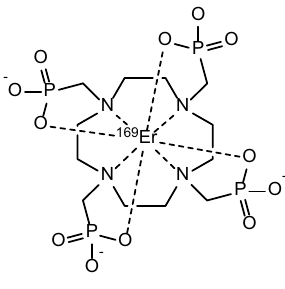
Fig. 9 Molecular Structure of [ 169